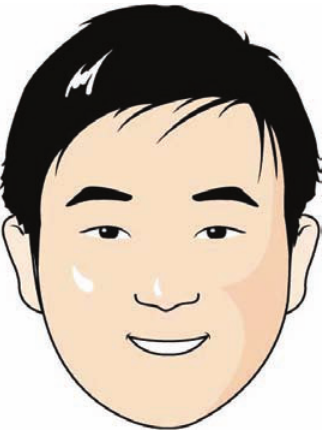
Figure 7: Automatic face caricature generation result of the person in Figure 3. Table 1: Quantitative results of our proposed algorithm.